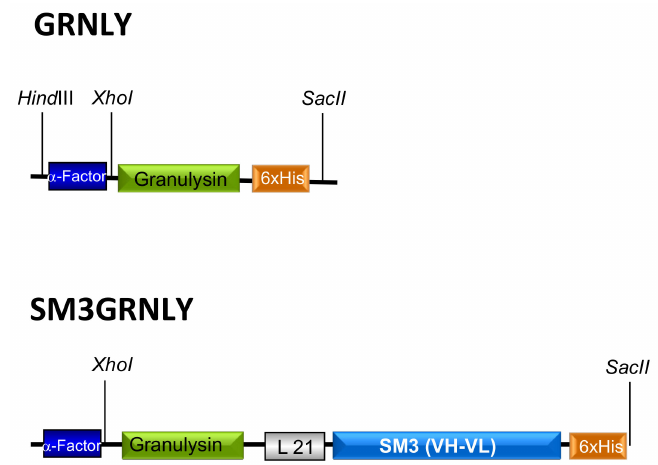
Figure1. Schematicrepresentationsofgranulysin(GRNLY)andoftheimmunotoxinbetweengranulysin and the anti-Tn scFv SM3 (SM3GRNLY). The α -Factor signal peptide is used to direct secretion of the recombinant proteins in Pichia pastoris , and the 6xHis tag is appended for immunodetection and a ffi nity purification,